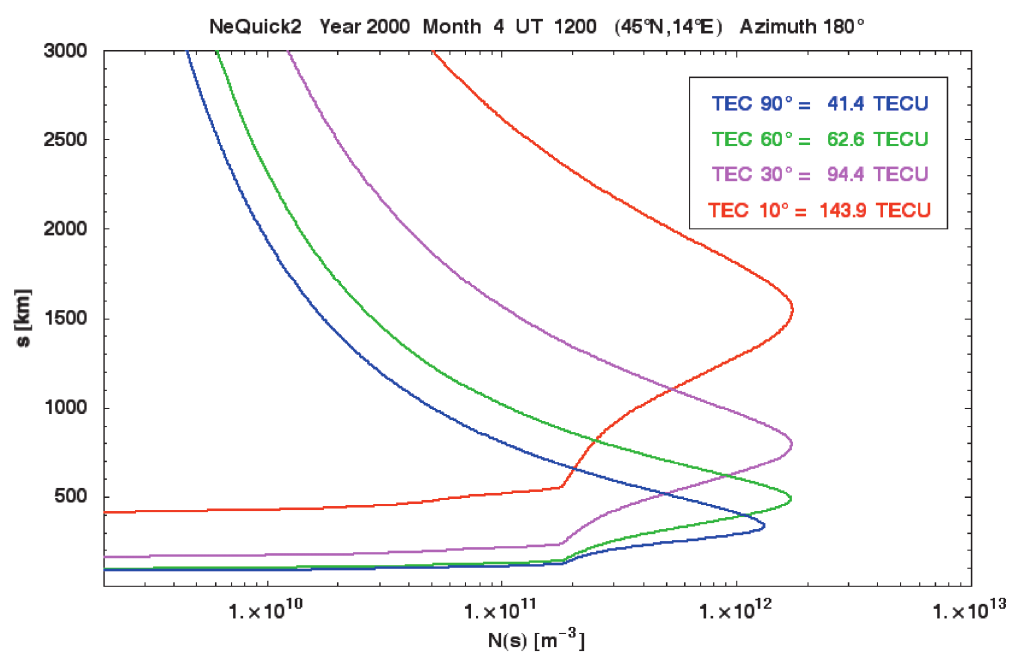
Fig. 2. Example of NeQuick 2 profiles and TEC along ray-paths. Different colors correspond to different path elevation angles. 90º means vertical profile and